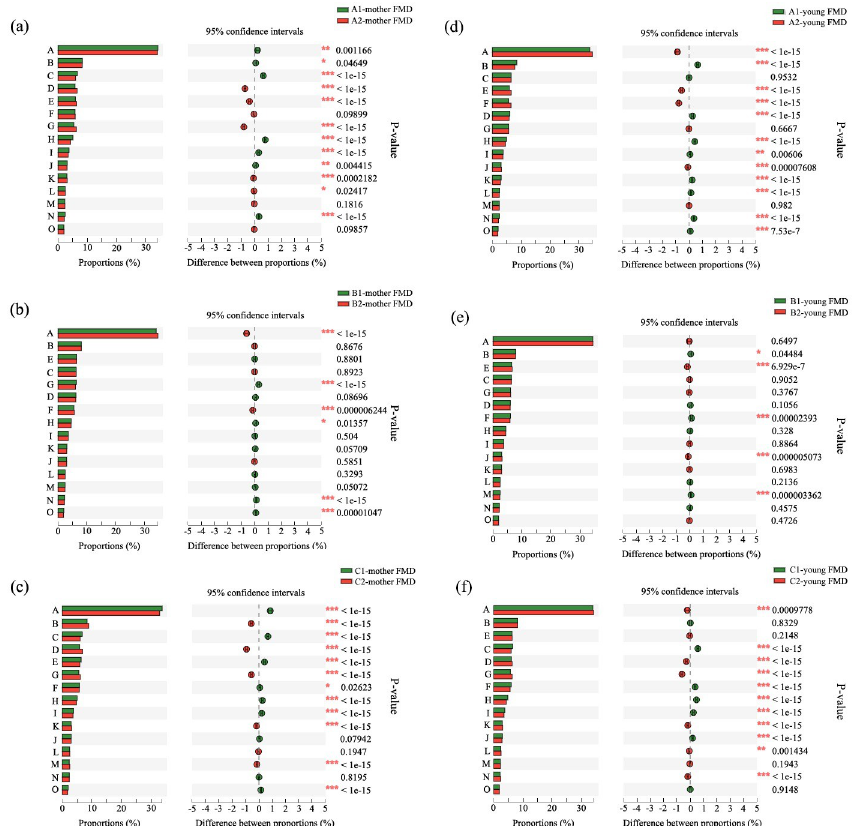
Fig 2. Comparison of functional differences before and after separation of female (a-c) and infant FMD (d-f) based on the COG database at different separation times (a, d: 80 days; b, e: 90 days; c, f: 100 days). A: Function unknown; B: Replication, recombination and repair; C: Amino acid metabolism transport and metabolism; D: Translation, ribosomal structure and biogenesis; E: Carbohydrate transport and metabolism; F: Transcription; G: Cell wall/ membrane/envelope biogenesis; H: Energy production and conversion; I: Inorganic ion transport and metabolism; J: Signal transduction mechanisms; K: Posttranslational modification, protein turnover, chaperones; L: Nucleotide transport and metabolism; M: Defense mechanisms; N: Coenzyme transport and metabolism; O: Lipid transport and metabolism.